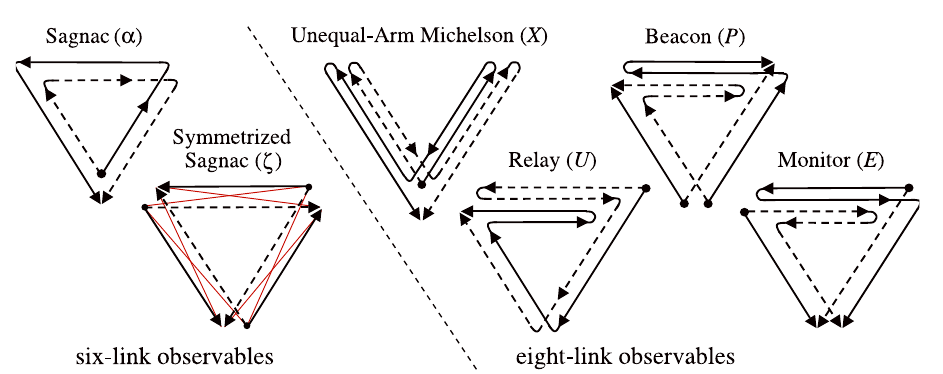
Figure 1: Time-Delay Interferometry (TDI). LISA-like detectors measure GWs by transmitting laser light between three spacecraft in triangular configuration, and comparing the optical phase of the incident lasers against reference lasers on each spacecraft. To avoid extreme requirements on laser-frequency stability over the course of the many seconds required for transmission around the triangle, data analysts will generate time-delayed linear combinations of the phase comparisons; the combinations simulate nearly equal-delay optical paths around the sides of the triangle, and (much like an equal-arm Michelson interferometer) they suppress laser frequency noise. Many such combinations, including those depicted here, are possible, but altogether they comprise at most three independent gravitational-wave observables. Image reproduced by permission from [447], copyright by